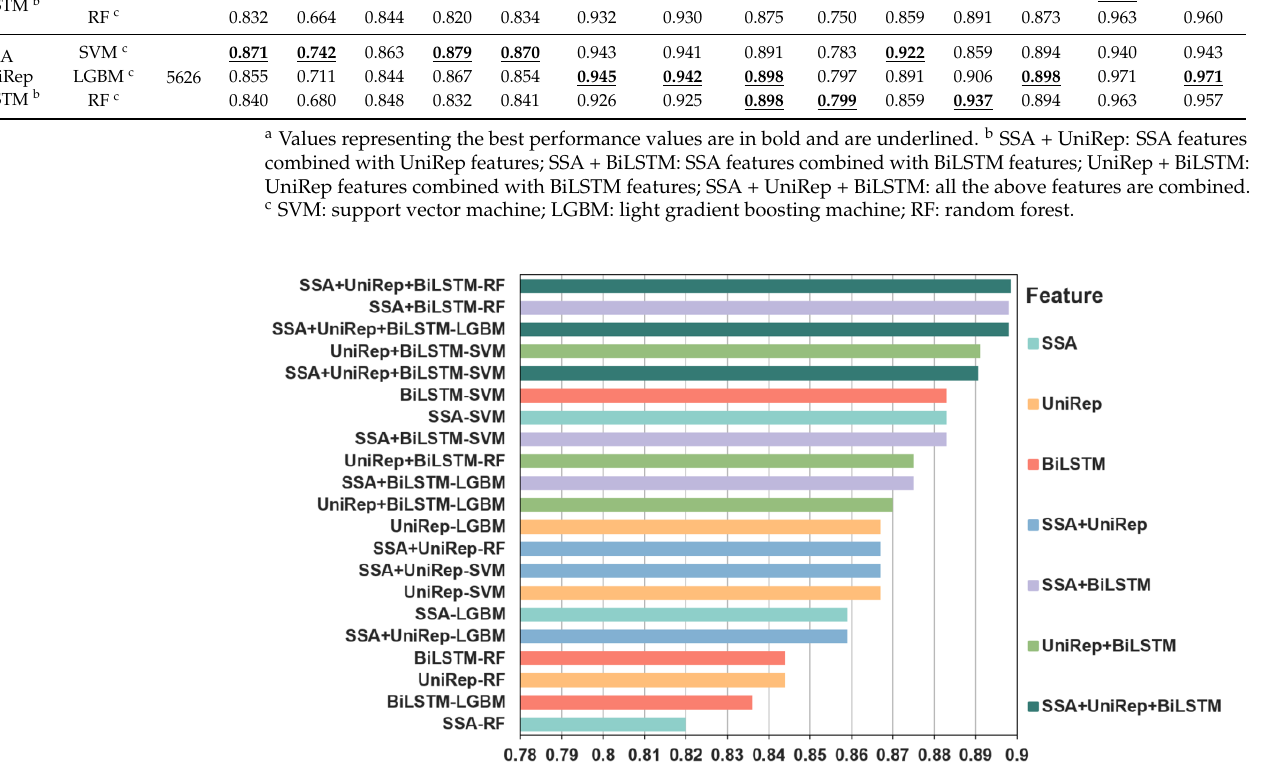
a Values representing the best performance values are in bold and are underlined. b SSA + UniRep: SSA features combined with UniRep features; SSA + BiLSTM: SSA features combined with BiLSTM features; UniRep + BiLSTM: UniRep features combined with BiLSTM features; SSA + UniRep +